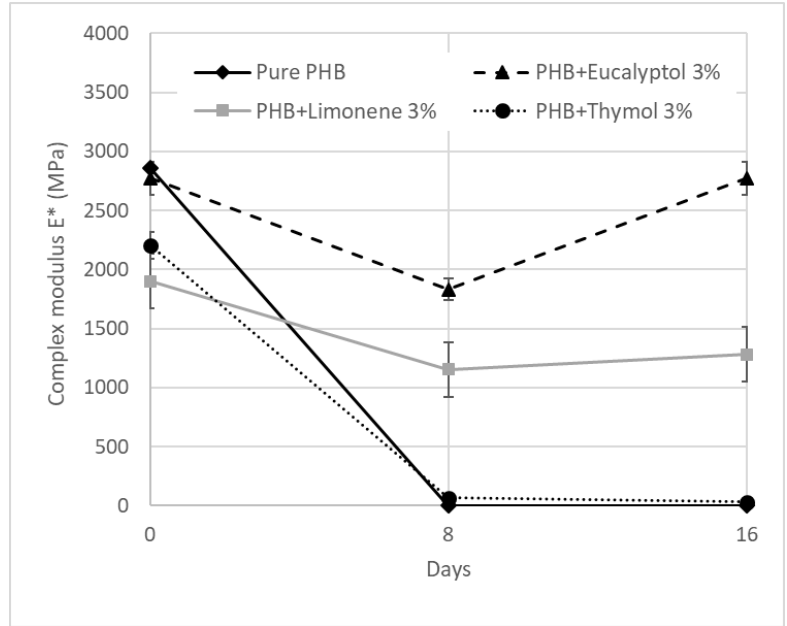
Figure 6. DMA: Complex modulus E* for PHB mixtures at 30 °C.